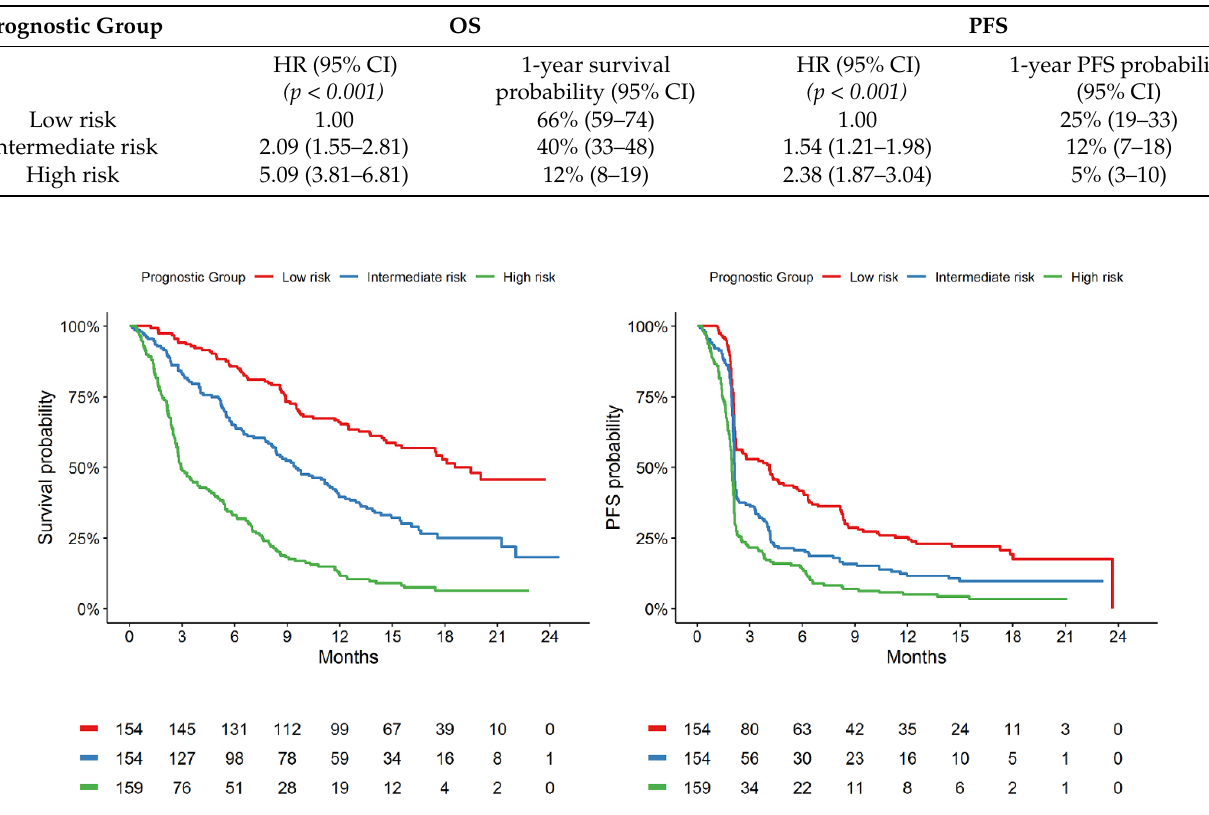
Figure 2. Kaplan–Meier estimates indicating differences in OS and PFS according to stratified machine-learning prognostic groups on validation cohort within IMvigor211 using curated-list GBM model.